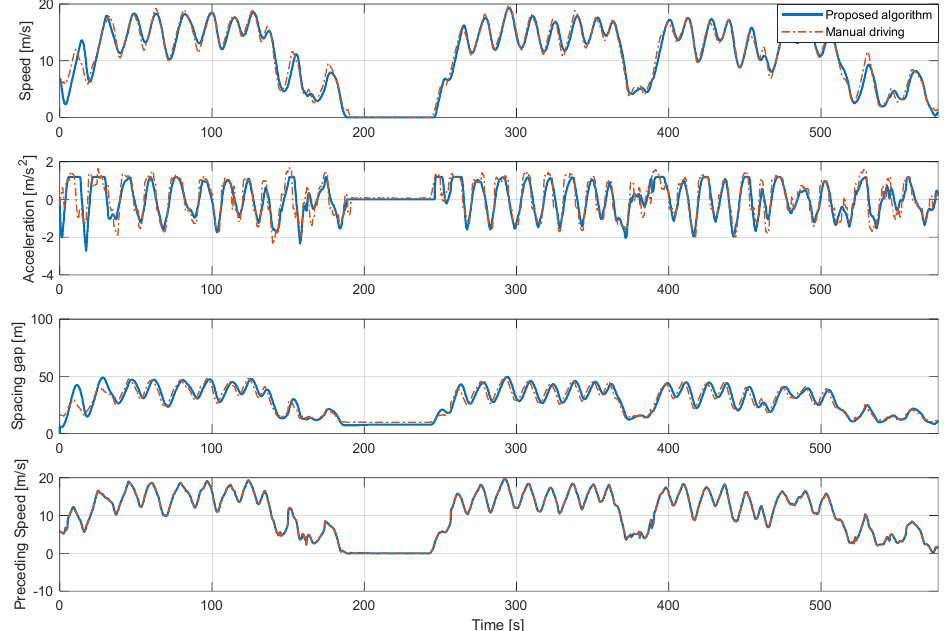
Figure 13. Driving simulation results of the proposed algorithm of 3rd driver for the entire route.